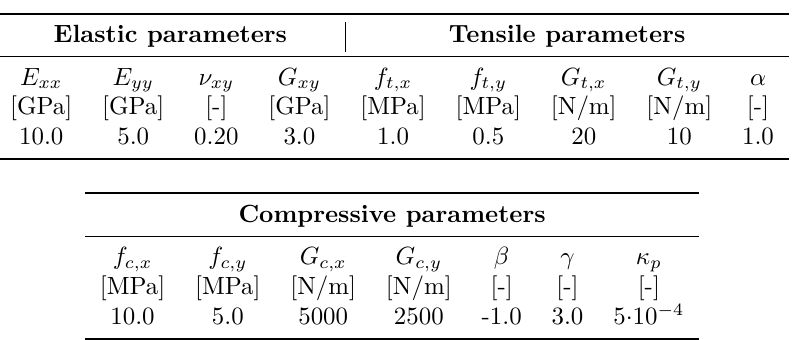
Table 1. Mechanical parameters considered for localization analysis